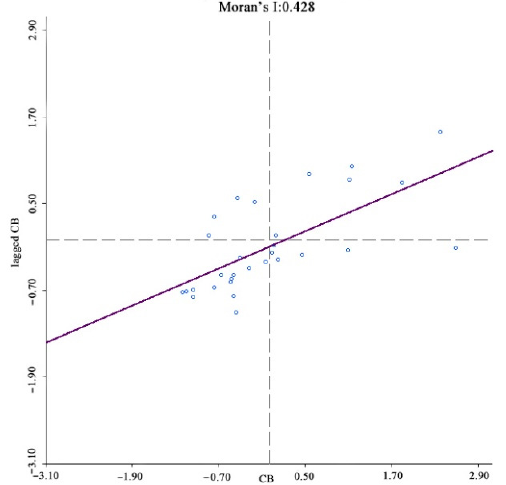
Figure 6. Global Moran’s I of coverage breadth growth.